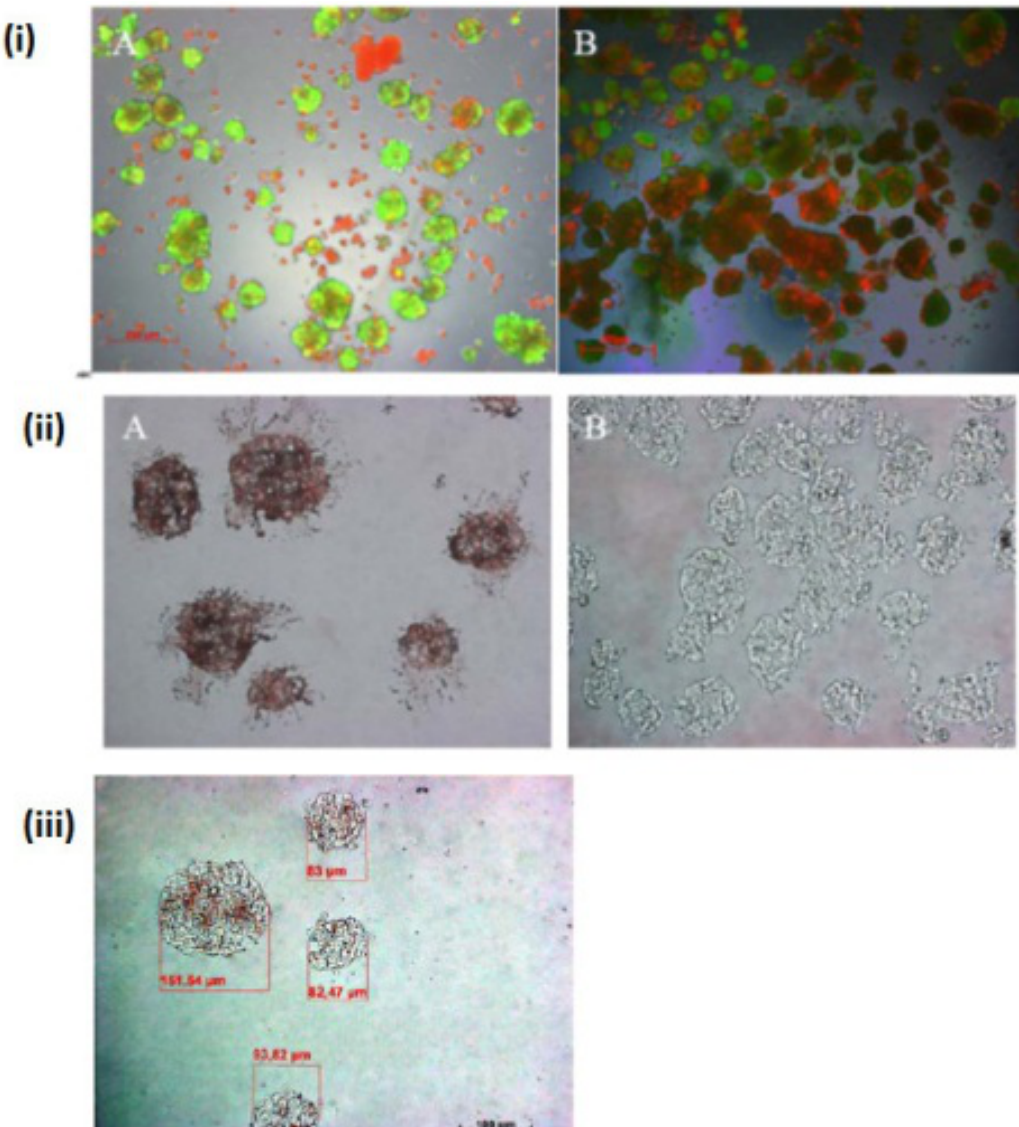
Figure 5. TUNEL staining test in spheroid culture. (i) A and B Vitality of cells in the spheroid (A) on day 4 and (B) on day 5 of culture; (Magnification 100×). (ii) A and B: (A) positive control, (B) Negative control of TUNEL staining (magnification 200×), (iii) A and B: TUNEL staining of 6- μ m sections of spheroids (magnification